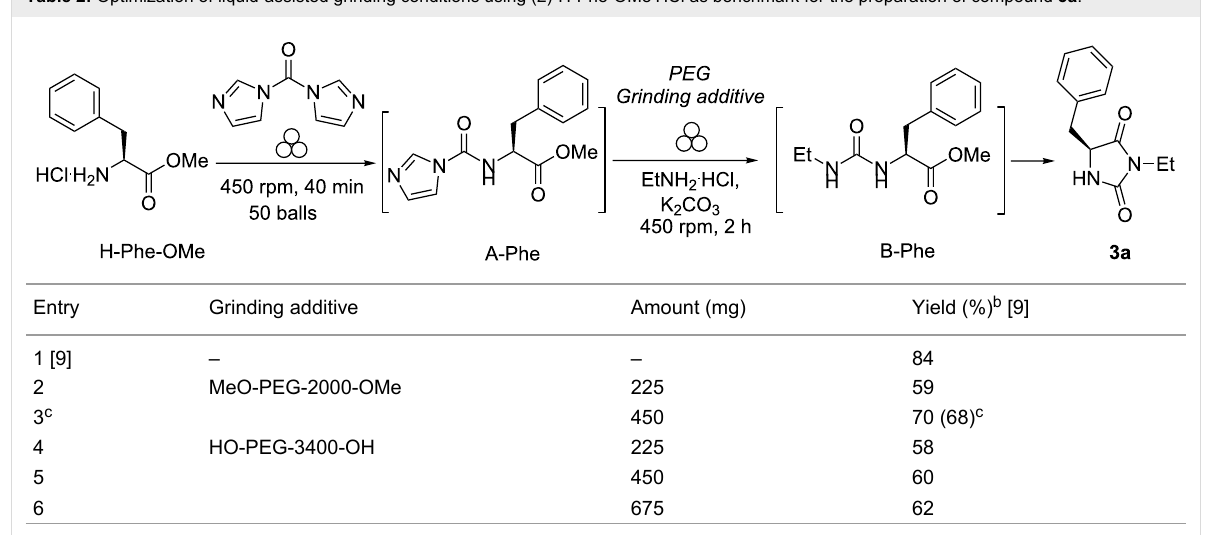
Table 2: Optimization of liquid-assisted grinding conditions using ( L )-H-Phe-OMe . HCl as benchmark for the preparation of compound 3a . a